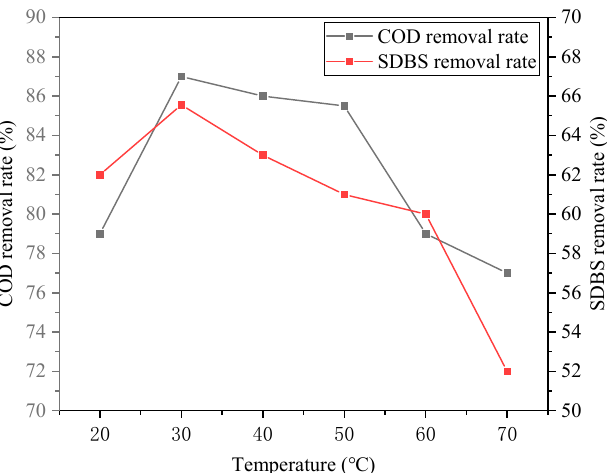
Figure 10. Effect of temperature on removal rates of COD and SDBS.